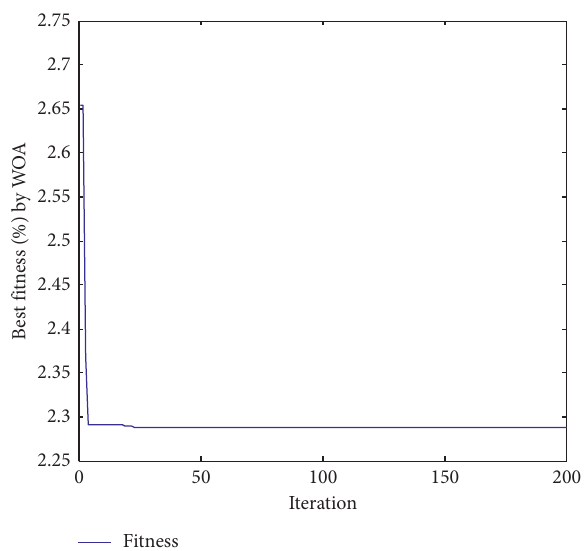
Figure 2: Searching process of the WOA-based FDNGM(1,1, k , c ) model in Case 1. Table 1: Parameters of the competitors in the two real-world cases.